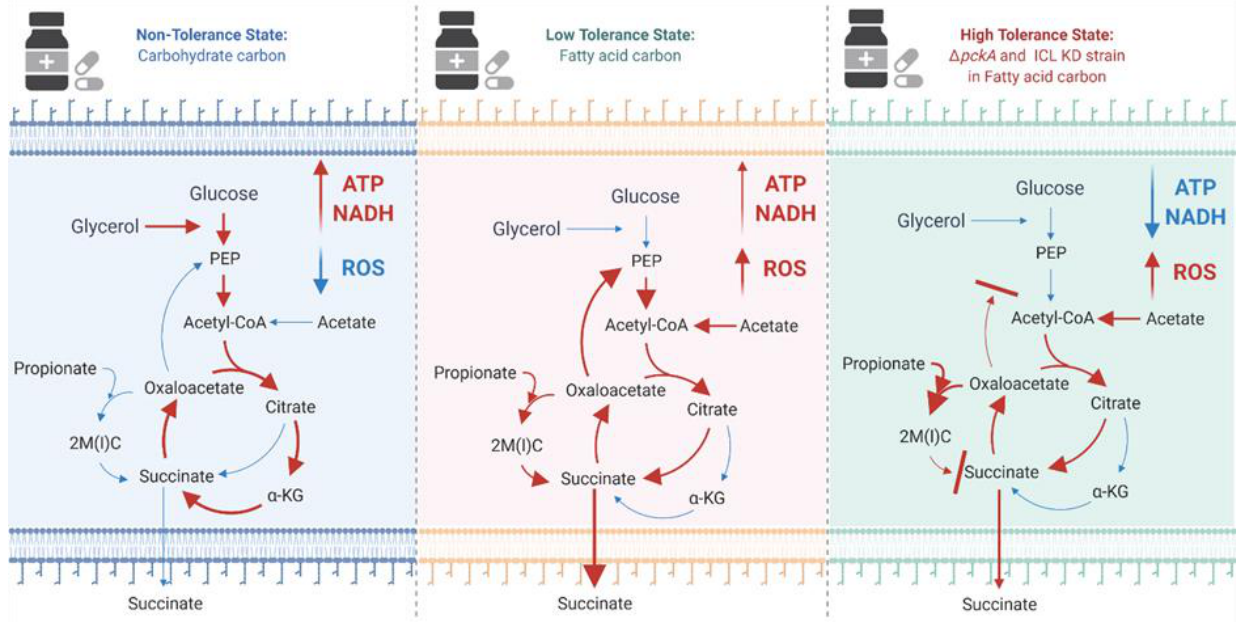
FIGURE 1 : The effect of carbon metabolism on drug tolerance of Mycobacterium tuberculosis. The new findings indicate that fatty acids (acetate or propionate) alter Mtb central carbon metabolism, triggering a dormant-like state and drug-tolerance. In glycerol media, glycolysis and TCA cycle are active to biosynthesize ATP and NADH. NADH serves as a substrate of ETC activity, leading to biosynthesis of high levels of ATP (Left panel). Fatty acids activate the methylcitrate cycle (MCC) and accumulates the reductive TCA cycle branch intermediates. Accumulated MCC intermediates alter ETC activity and increases the ROS level as compared to those in glycerol media. Succinate secretion is an additional activity involved in maintaining the membrane potential (Middle panel). ΔpckA and ICL KD in fatty acid media induce metabolic remodeling associated with high drug tolerance. Over-accumulated MCC intermediates, slowed TCA cycle activity, reduced ATP levels, induced ROS, increased NADH/NAD ratios, and a relatively stable membrane potential are mechanistic bases underlying fatty acid-induced drug tolerance of ΔpckA and ICL KD (Right panel). Figures were creat ed by